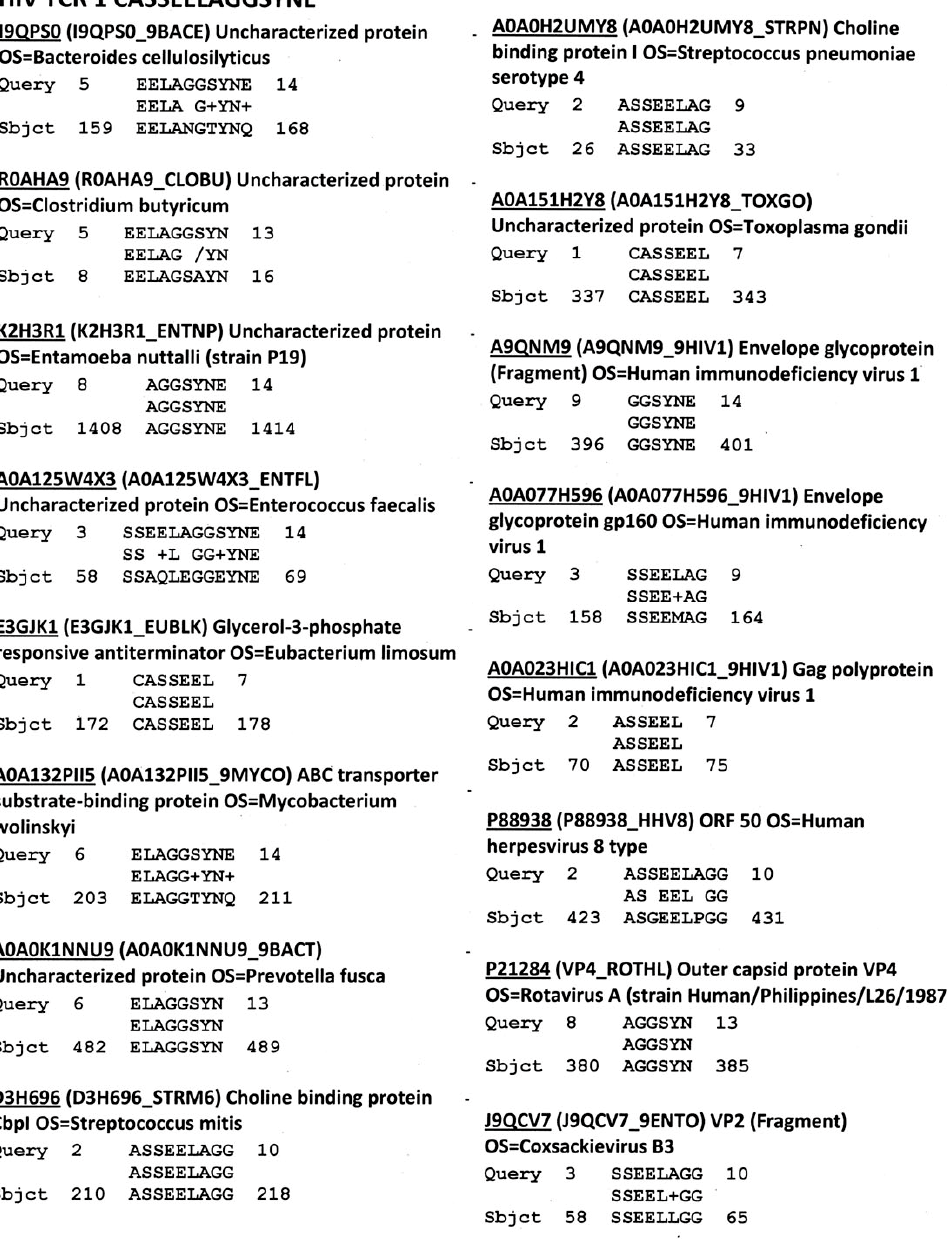
Figure 1. Typical (but partial) selection of HIV TCR-Microbiome protein similarities, including similarities to HIV itself (BLAST 2.0 search, UniProt protein database and virus database, E = 1000, no gaps). Accession numbers are for the UniProt protein database